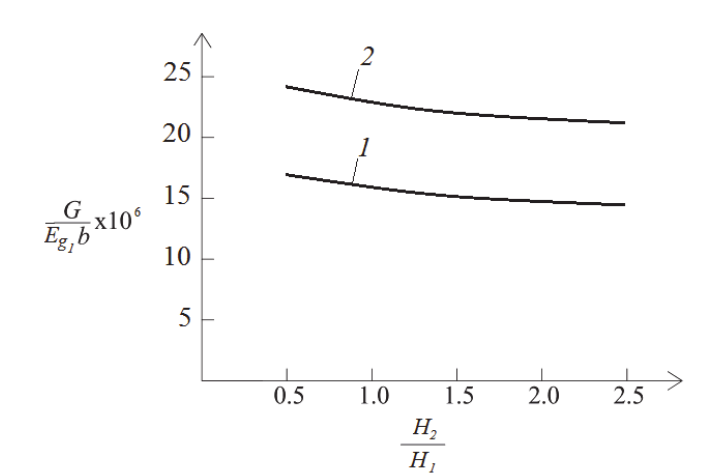
Figure 4: The strain energy release rate in non-dimensional form presented as a function of 2 1 / H H ratio (curve 1 – for the beam configuration with delamination located between layers 2 and 3 (refer to Fig. 3a), curve 2 – for the beam configuration with delamination located between layers 1 and 2 (refer to Fig. 3b)).